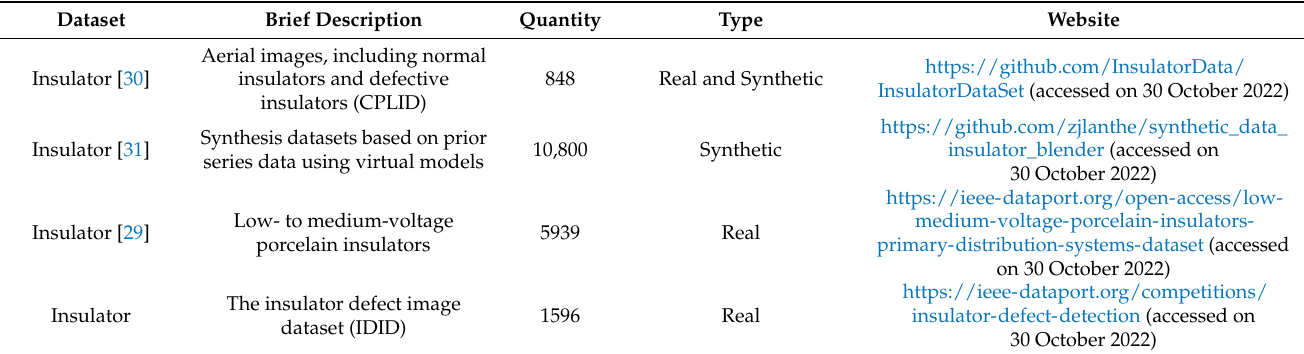
Table 1. Public dataset of